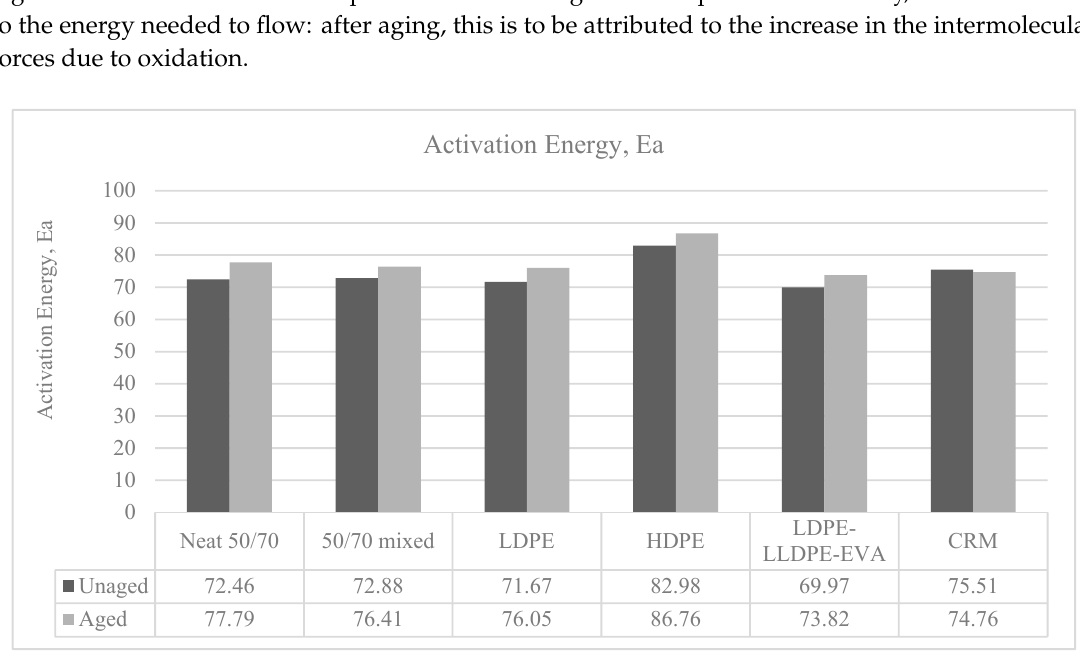
Figure 3. Effect of polymer introduction on the activation energy, pre and post aging. Figure 3. E ff ect of polymer introduction on the activation energy, pre and post